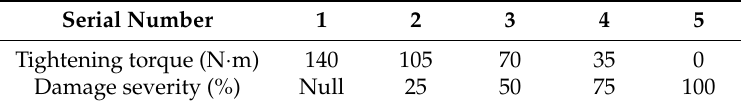
Table 4. Operating conditions of damage severity identification.